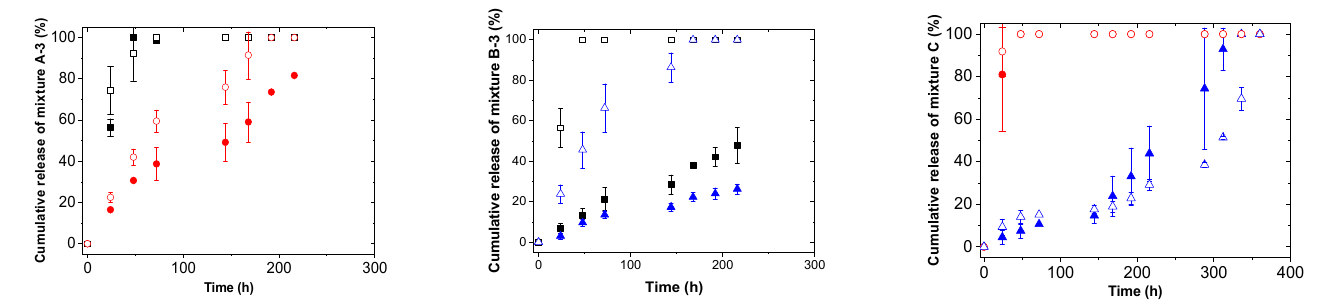
Figure 2. Release kinetics as a function of temperature for different mixtures at pH 6. ■ DBBH at 25 °C, □ DBBH at 37 °C, ● Benzophenone-4 at 25 °C, ○ Benzophenone at 37 °C, ▲ Salicylic acid at 25 °C, Δ Salicylic acid at 37 °C.